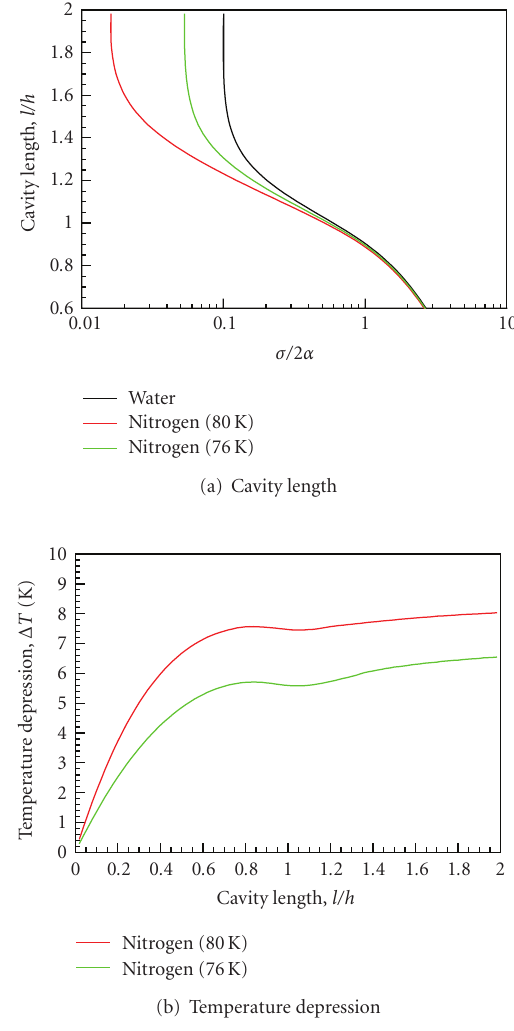
Figure 8: Modified results in the case of LN2 and cold